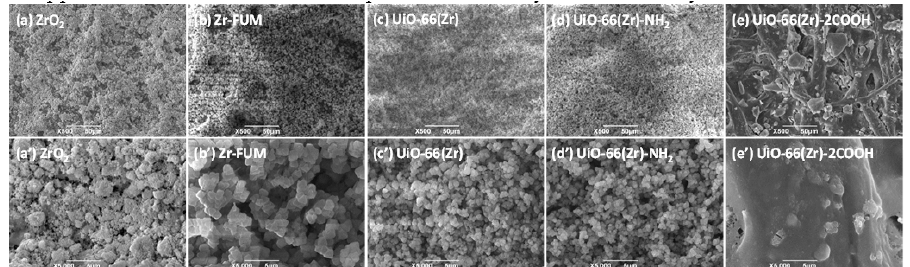
Figure 2. SEM images of ( a ) and ( a’ ) ZrO 2 -coated paper, ( b ) and ( b’ ) Zr-FUM-coated paper, ( c ) and ( c’ ) UiO-66(Zr)-coated paper, ( d ) and ( d’ ) UiO-66(Zr)-NH 2 -coated paper, and ( e ) and ( e’ ) UiO-66(Zr)-2COOH-coated paper, and (a’–e’) are the close-up images of the representative areas in (a–e). ( Note : The coated amount of ZrO 2 and MOFs was 0.5 g, and the solution volume for coating was 100 mL with 0.1 g corn.